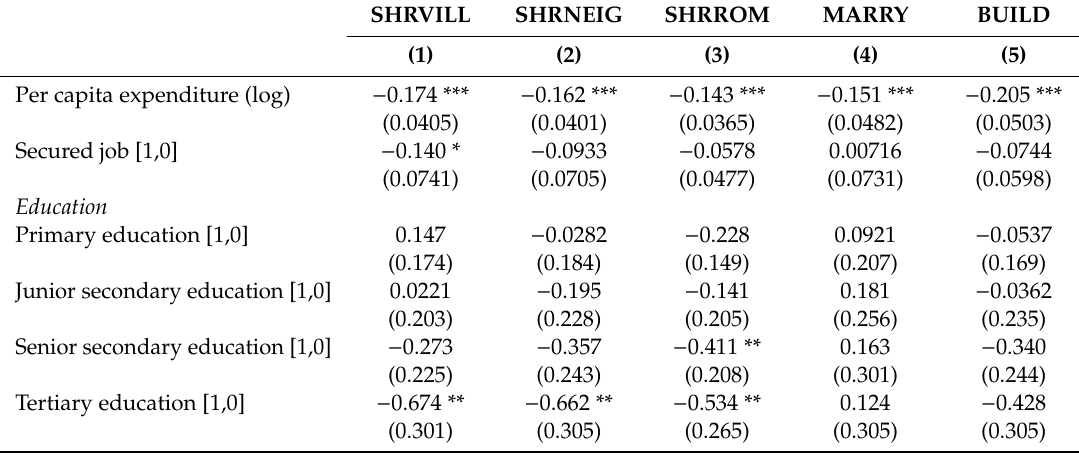
Table 2. Regression results (Fixed-e ff ect conditional logit